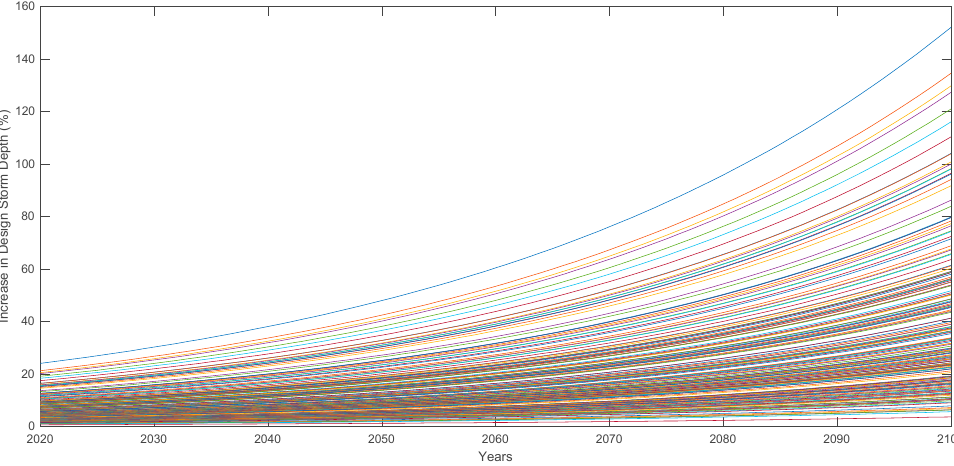
Figure 4. Two hundred projections of increases in the precipitation depths of rare storm events.